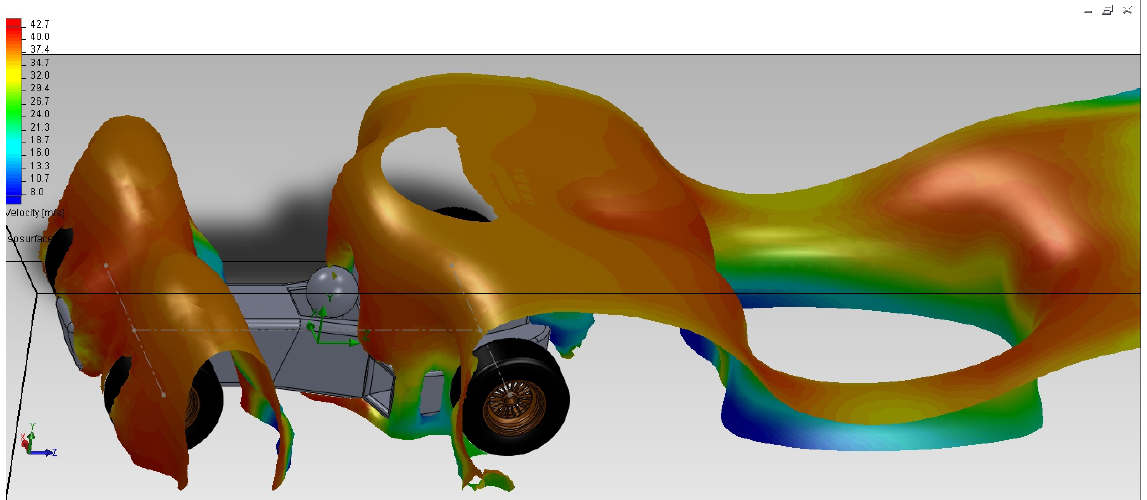
Figure 8. Spatial air flow velocity distribution on